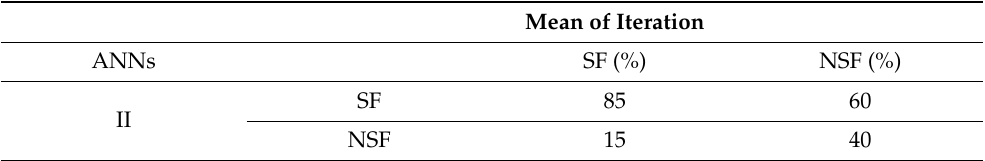
Table 5. II architecture’s confusion matrix: the diagonal elements, highlighted in red, correspond to the number of correctly classified entries (True Positive = 85% and True Negative = 40%). The off-diagonal elements correspond to wrong classifications, False Negative and False